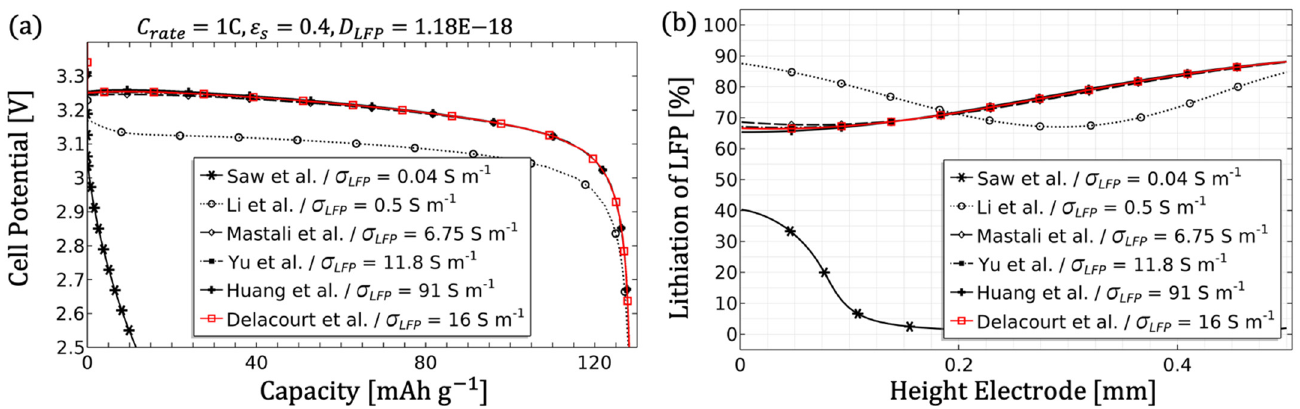
Figure 4. Parameter variation of the LFP electrode conductivity. The discharge performance at 1C with an optimised ε s = 0.4 is shown in ( a ), and the lithiation along the electrode height at an DoD = 1 is illustrated in ( b ).